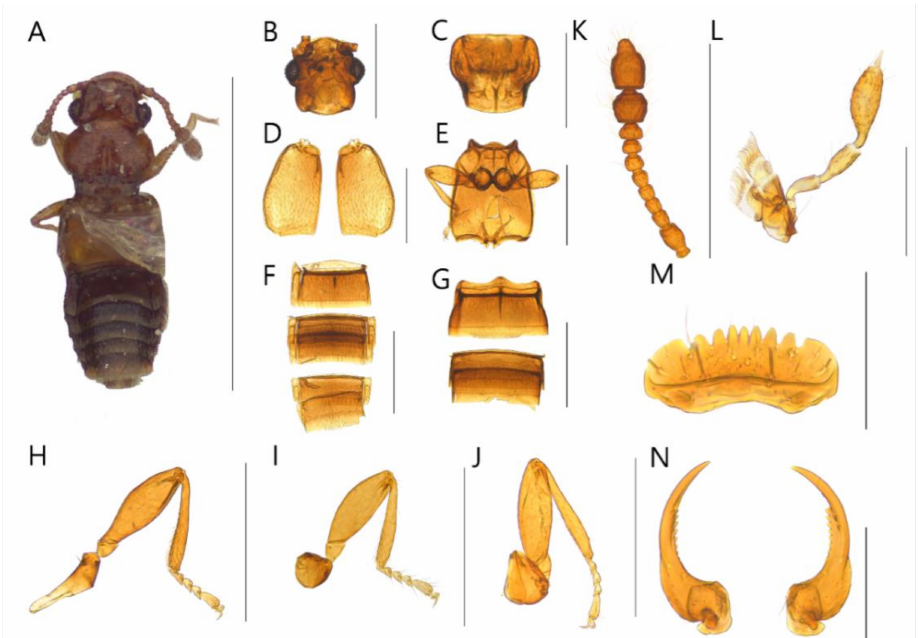
Figure 3. Male habitus of Edaphus odaesanensis sp.n.: ( A ) dorsal view; ( B ) head; ( C ) pronotum; ( D ) elytra; ( E ) meso and metasternum; ( F ) abdominal tergites; ( G ) abdominal sternites; ( H ) fore leg; ( I ) middle leg; ( J ) hind leg; ( K ) antenna; ( L ) maxillary palp; ( M ) labrum; ( N ) mandibles. Scale bars: ( A ) = 1 mm; ( B – K ) = 0.3 mm; ( L – N ) = 0.1 mm.